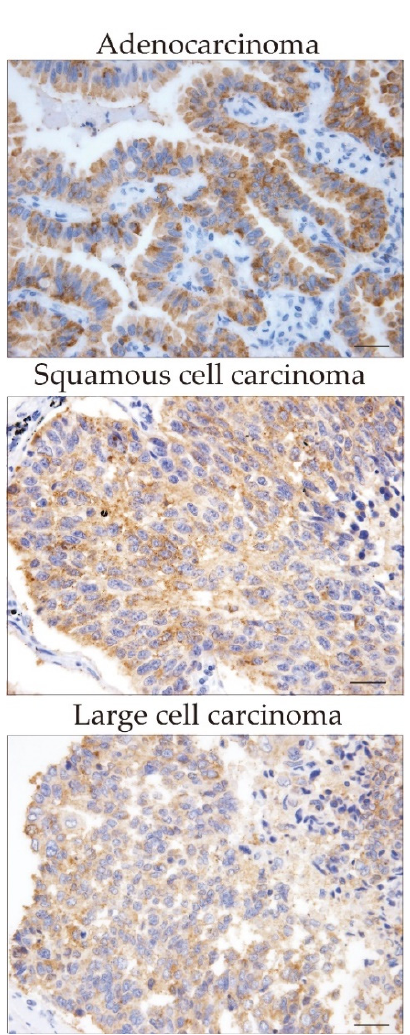
Figure 1. Expression of CXCL12 in tumor tissue from different histological types of non-small cell lung carcinoma. The expression of CXCL12 was evaluated as described under material and methods. Scale bars indicate 50 µm.